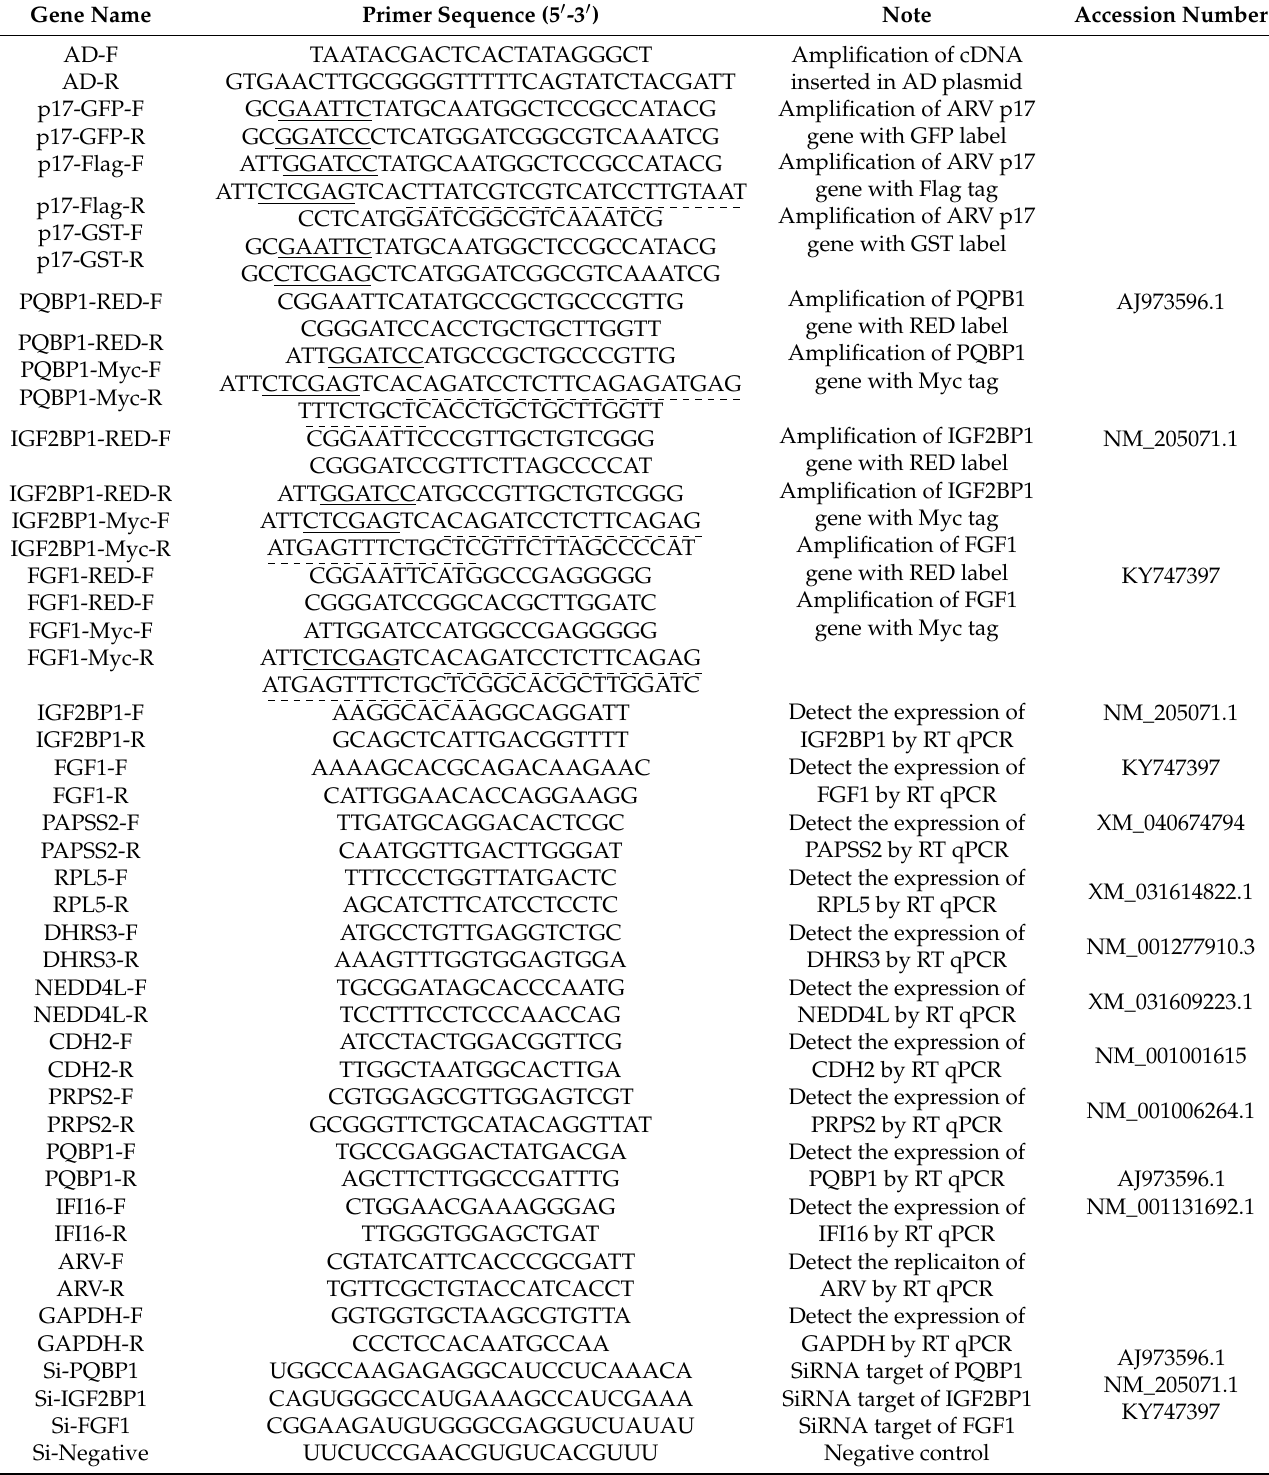
Table 1. Sequence of PCR